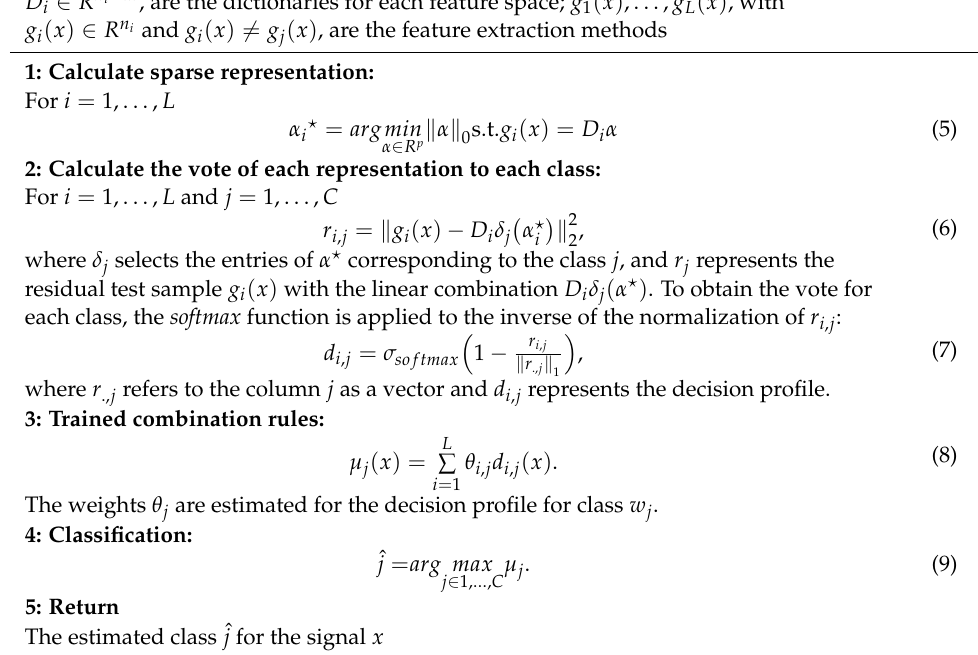
Algorithm 1. Sparse representation fusion classification (SRFC). D 1 , . . . . D L ,